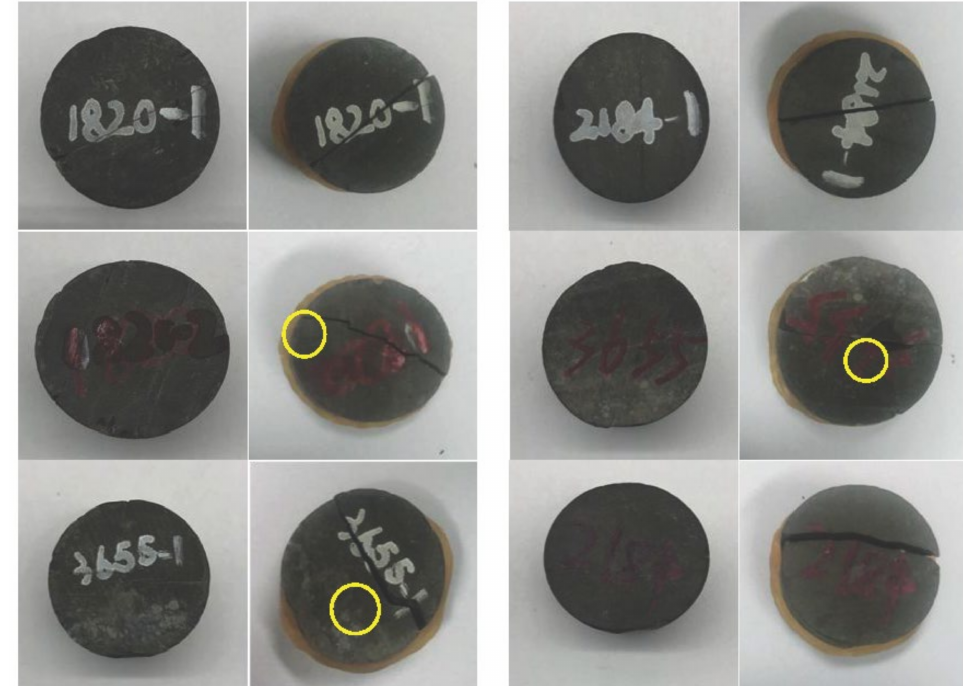
Figure 5. Samples before and after tests.